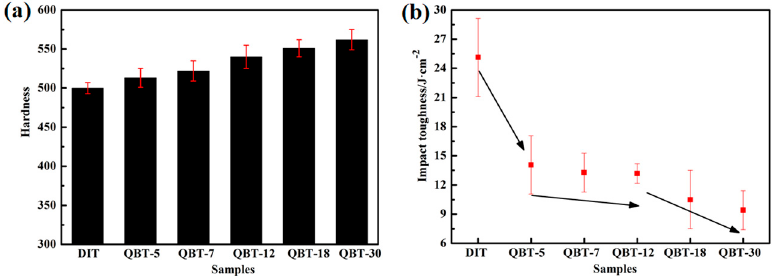
Figure 11. Mechanical properties of investigated steel. ( a ) hardness; ( b ) impact toughness.